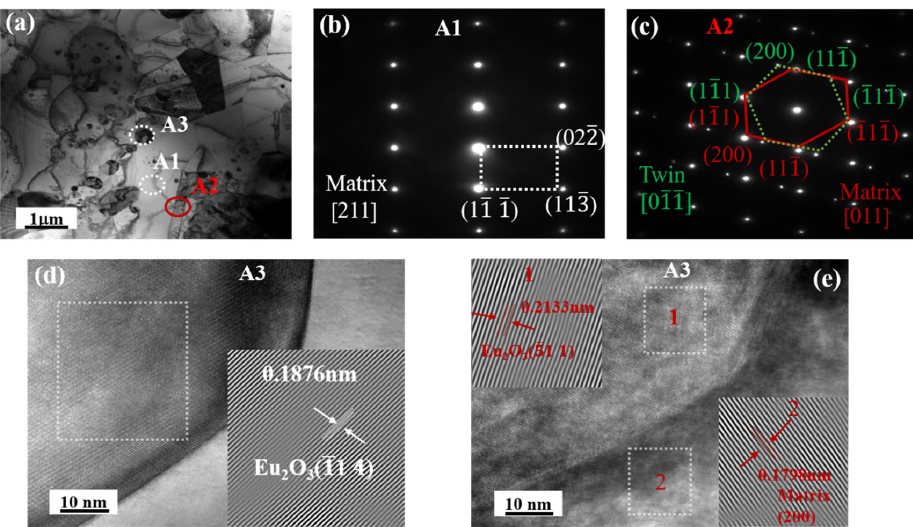
Figure 9. TEM bright field images of the HP10 composite: ( a ) A bright TEM image; ( b ) the corre- sponding SAED patterns of matrix; ( c ) the corresponding SAED patterns of twin; ( d ) obtained from the regions marked in A3 in ( a ); ( e ) obtained from the regions marked in 1 and 2 in ( d ).